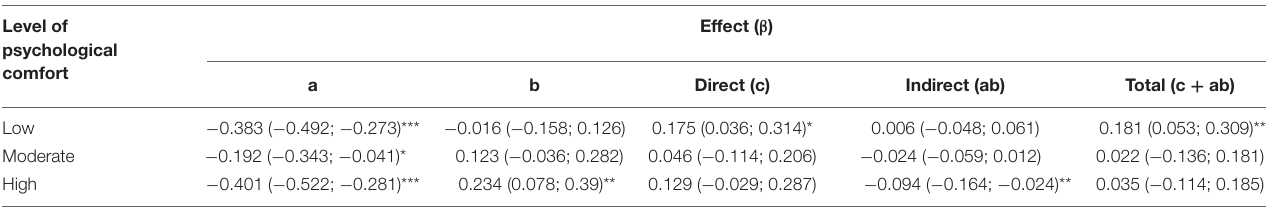
TABLE 3 | Latent variable: Level of psychological comfort.